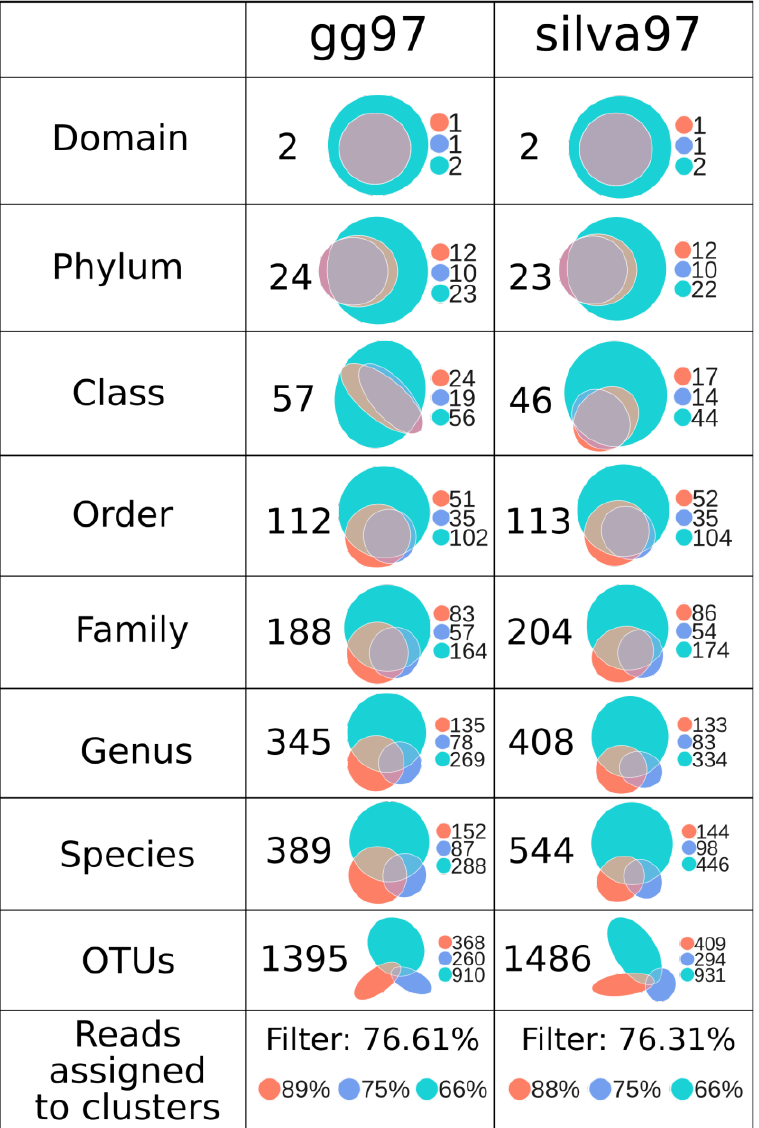
Figure 3. Taxa and OTU comparison from the gg97 and silva 97 BioSet clusters. Euler diagrams show the proportion of unique and shared OTUs for each region (V3: coral, V4: blue, V3V4: turquoise). Total unique taxa for all taxonomic levels plus raw OTUs (no taxonomic classification) were presented on the left part of each box. The legend on the right shows the total number of unique OTUs per region. Percentage of reads assigned to clusters and richness and diversity for each region are shown in the lower panel.